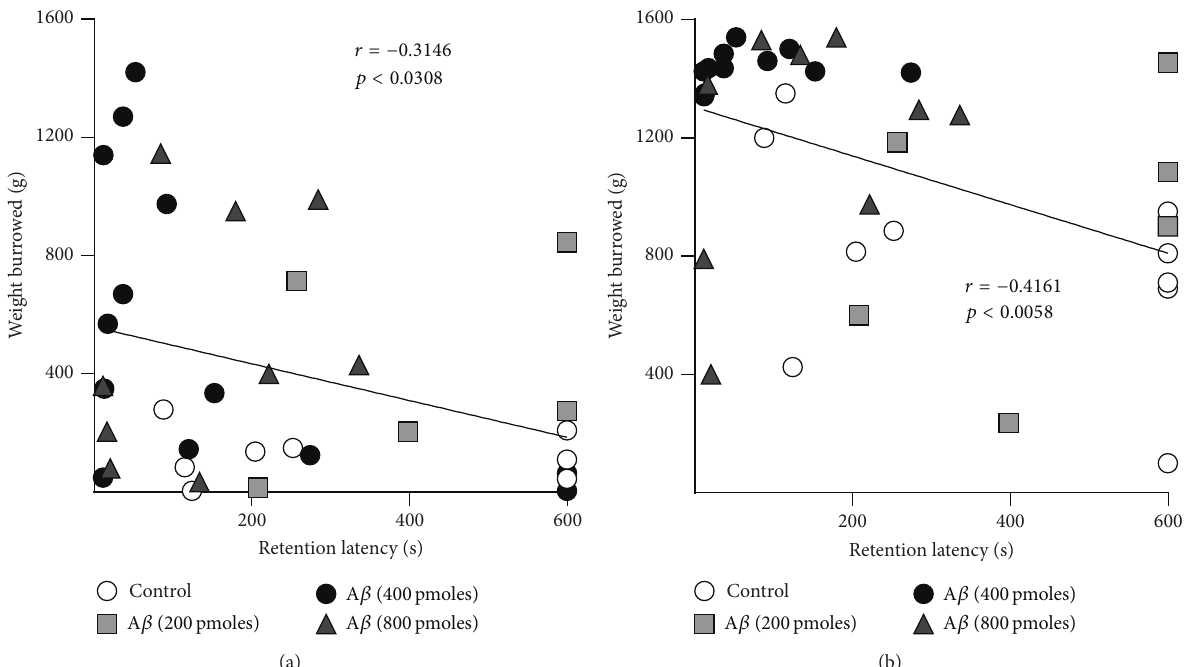
Figure 5: Correlation between A 𝛽 impairment in contextual memory and the increase in burrowing behavior. The median of the weight burrowed during 2h (a) or 18 h (b) is plotted against the median of the retention latency score from each animal treated with MF12 (control) or 200, 400, and 800 pmoles of A 𝛽 ( 𝑛 = 6–11